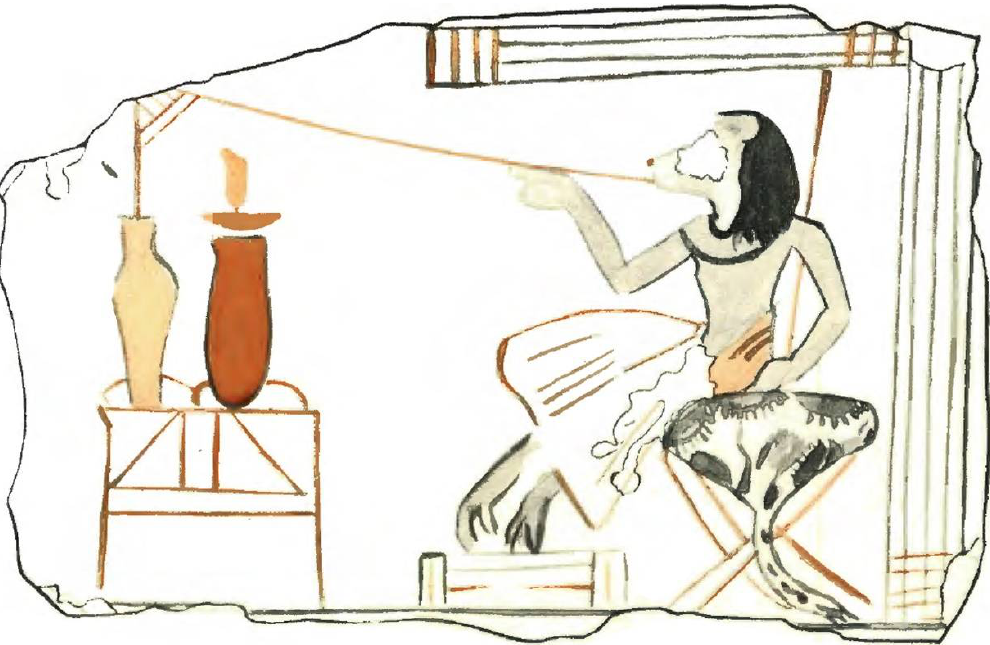
Figure 10. Seated primate drinking from a tube (IFAO inv. no. 3263), limestone flake, Deir el-Medina, Ramesside period (Line drawing taken from Vandier d’Abbadie (1937), pl. 48, courtesy of the Institut Français d’Archéologie Orientale, Cairo).